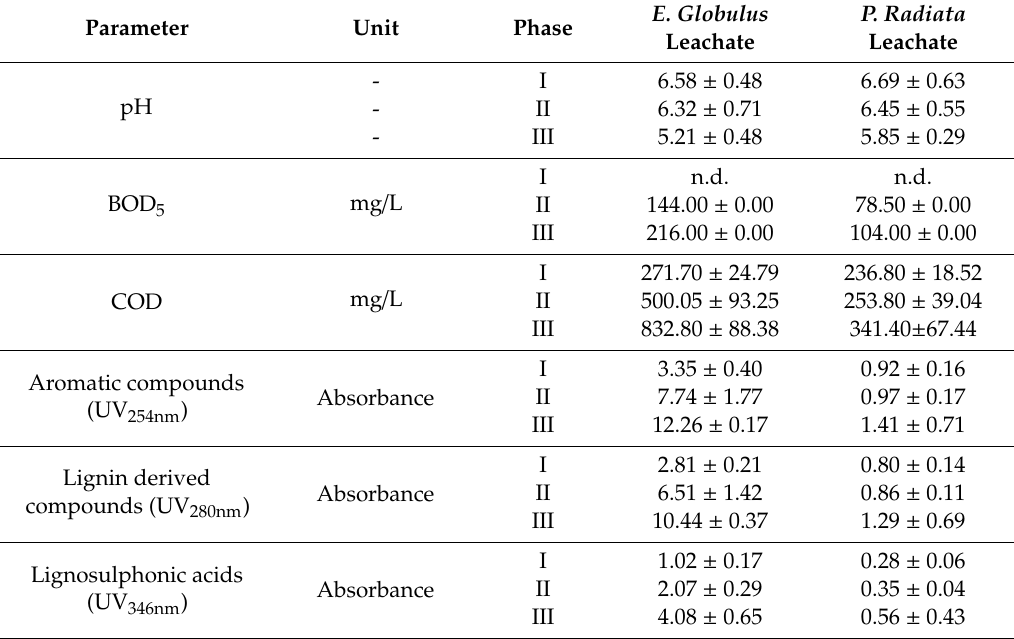
Table 1. Physico-chemical characteristics of the P. radiata and E. globulus